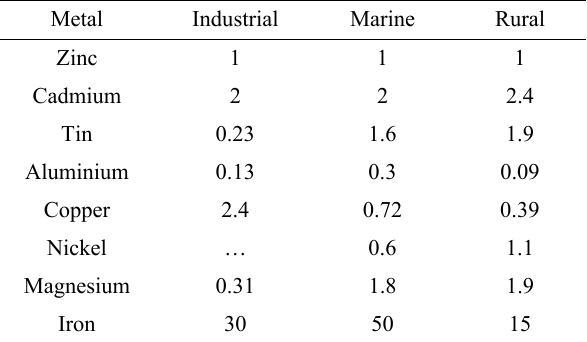
Fig. 17 Effect of zinc coating thicknesses and coating methods on coating life in industrial atmospheres. Reproduced with permission from Ref. [90], © ASM International, 2005. Table 4 Comparison of corrosion rates* of zinc and other common commercial